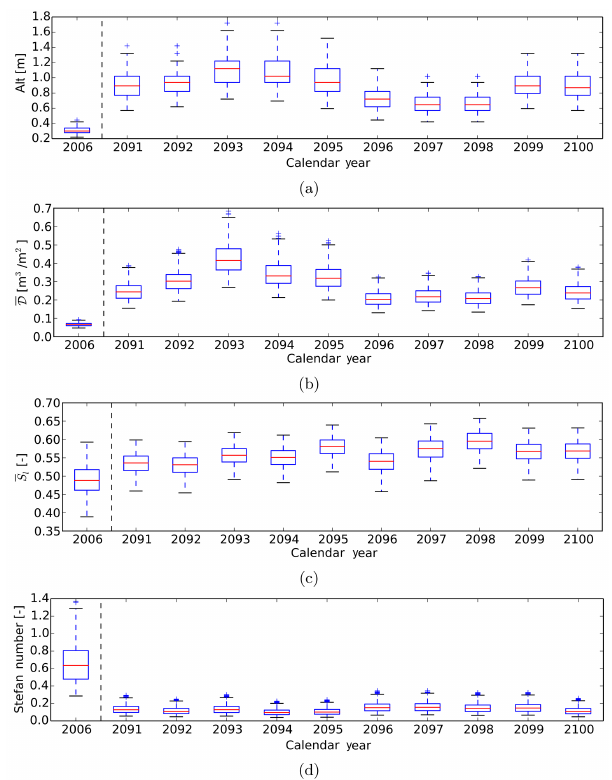
Figure 4. Boxplots of projected metrics including (a) ALT, (b) an- nual thaw depth-duration, (c) annual mean liquid saturation, and (d) Stefan number for year 2006 and from 2091 to 2100. The bot- tom and top of the boxes are the first and third quartiles, the red lines are medians, the whisker lengths are 1.5 times the interquar- tile range (50%), and the plus symbols are outliers.